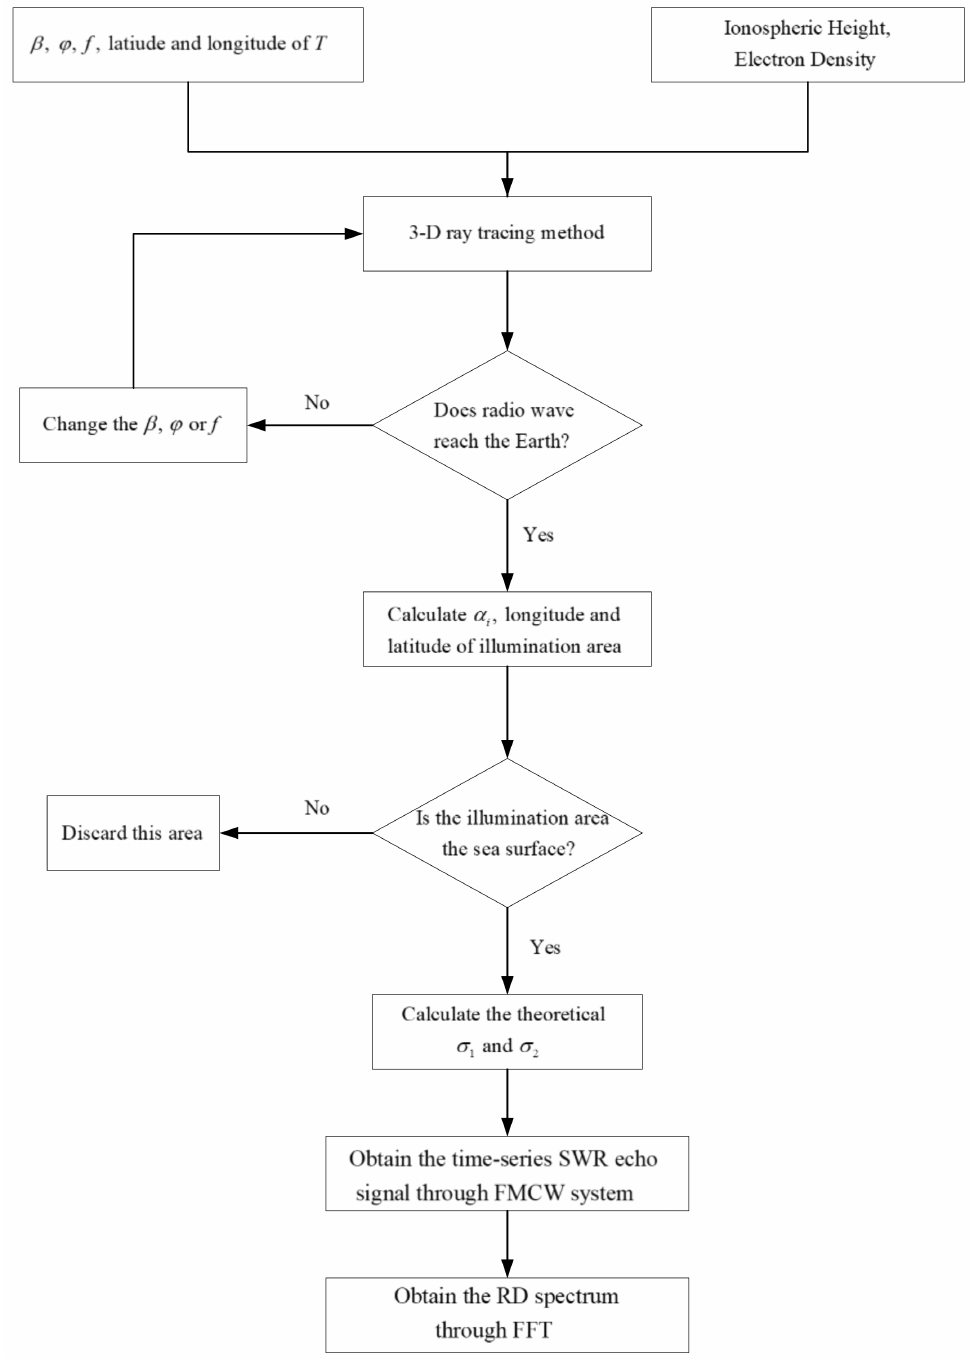
Figure 2. Diagram of the process to obtain the SWR ocean time-domain echo spectrum: β is the elevation angle, ϕ T is the azimuth angle, f is the radio wave frequency, T is the transmitting station, and σ 1 and σ 2 are the first-order and second-order cross-sections,